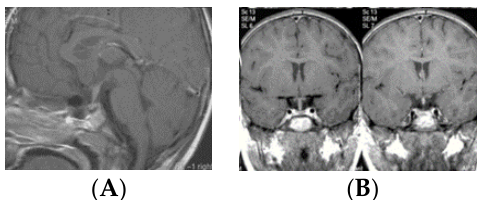
Figure 6. Type V. Post-contrast MR, sagittal ( A ) and coronal ( B ) views of a patient with S-GCT. Note the thickened pituitary stalk. This seven-year-old girl presented with 18-month history of